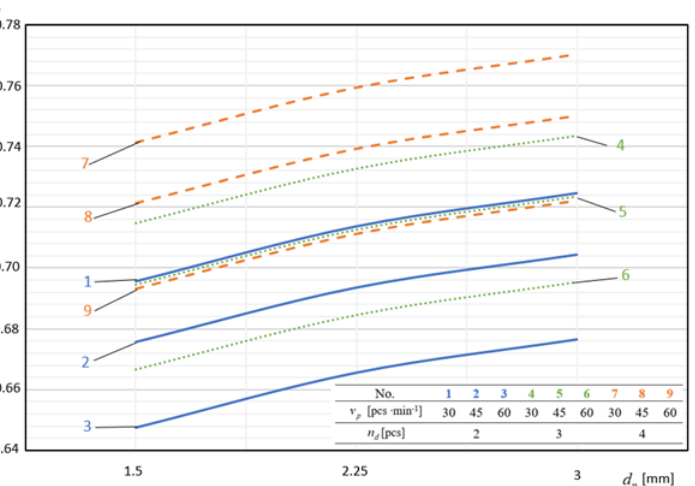
Figure 10. Influence of the depth of incisions of the outer layer of onions on shaping the efficiency of the machine at constant parameters 𝑝 = 4 bar and ℎ 𝑑 = 40 mm.